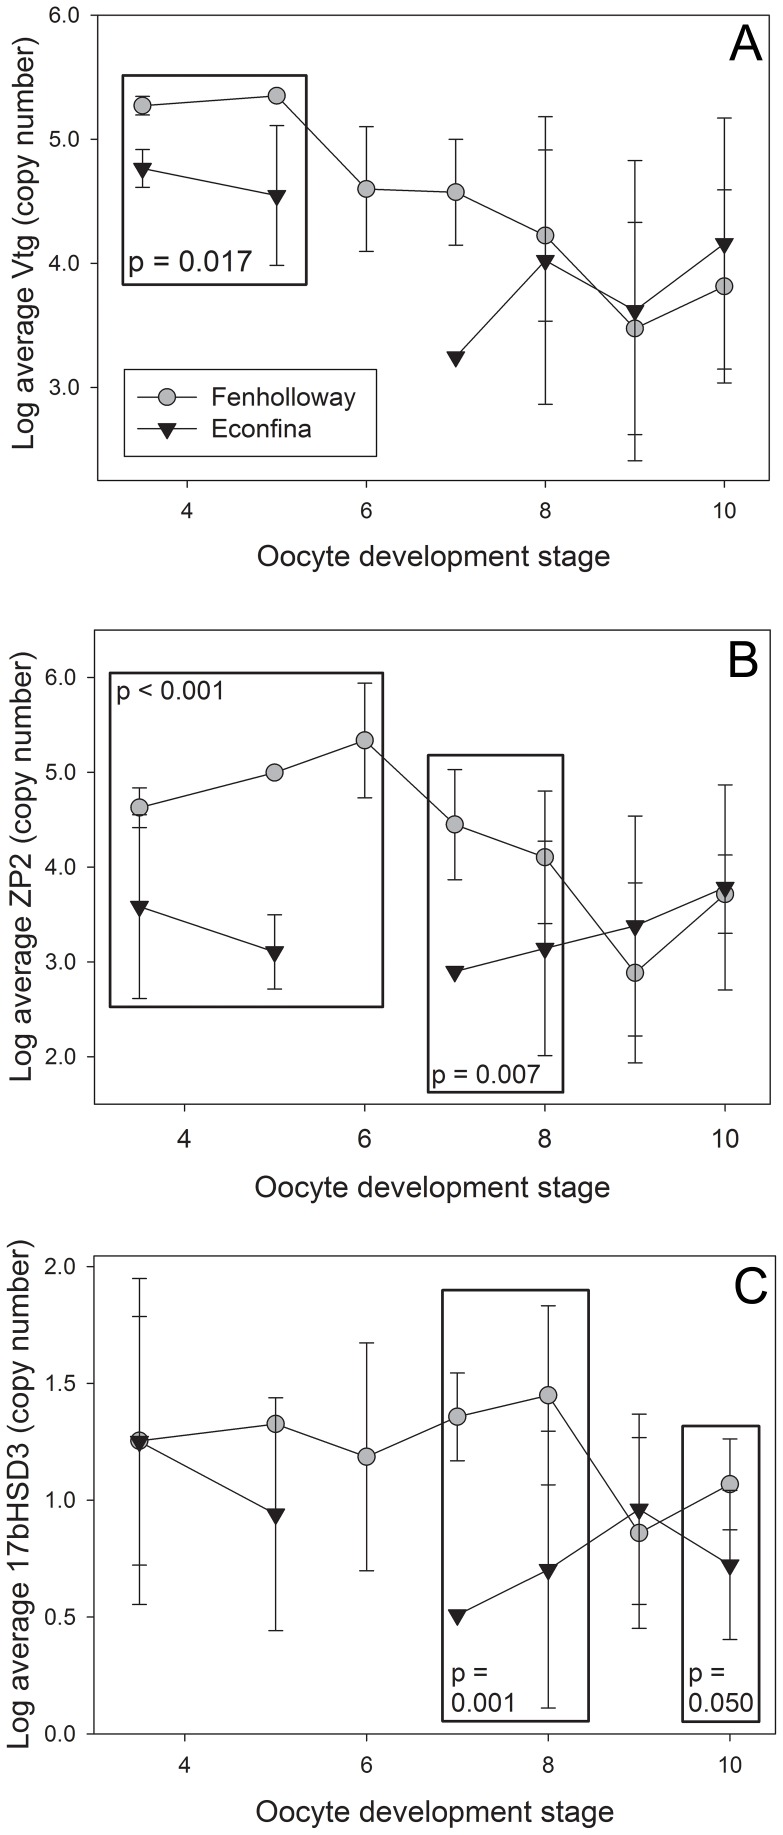
Focused hepatic gene expression patterns in female Eastern mosquitofish (Gambusia holbrooki) using qualitative polymerase chain reaction analysis.Gene expression of (A) vitellogenin (vtg), (B) zona pellucida glycoprotein 2 (zp2), (C) 17β-hydroxysteroid dehydrogenase 3 (17βhsd3) was analyzed between paper mill exposed (Fenholloway) and reference (Econfina) collection sites. Each point represents the mean of each group and error bars represent standard deviation; time points with no standard deviation have an N of 1. A box indicates statistical significance between groups at the selected oocyte developmental stages as determined using a Student's t-test with p<0.05.